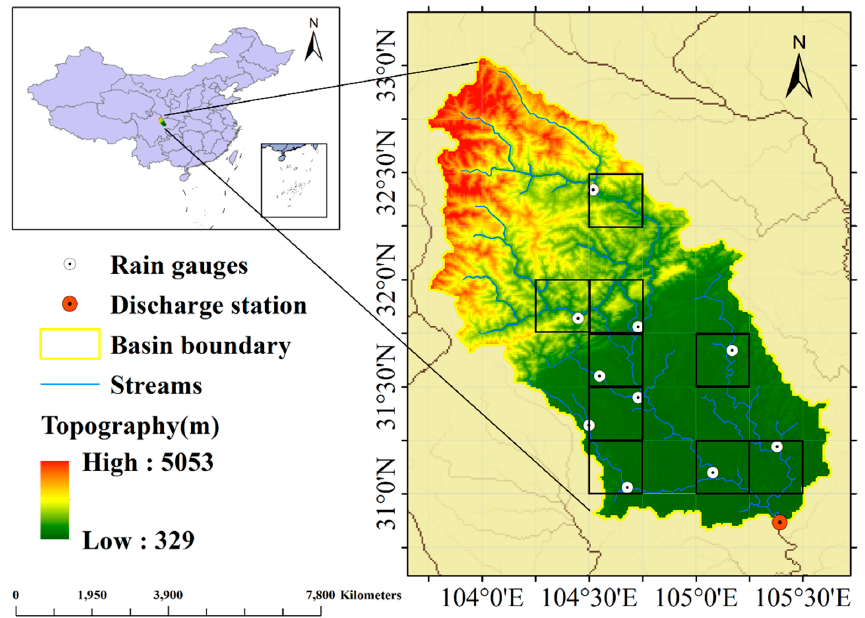
Figure 1. The Fujiang River basin of the Shehong hydrological station and locations of rain gauges. Black squares represent the 9 selected 0.25° × 0.25° grids for precipitation comparison.